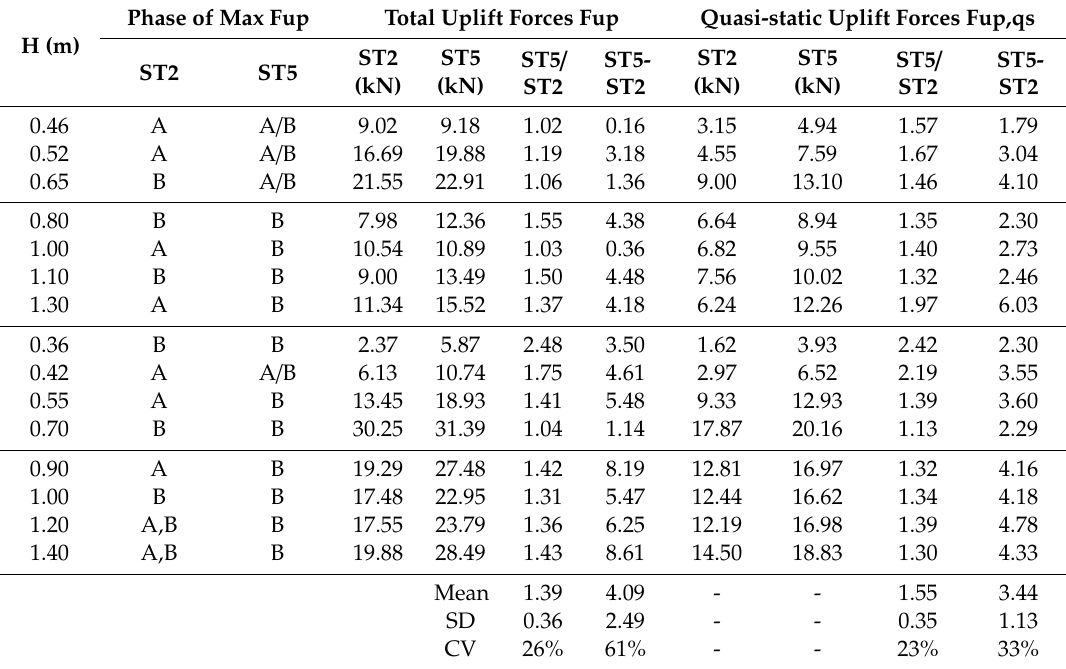
Table 4. Ratios of maximum total uplift forces of the deck with solid diaphragms (ST5) to the maximum values of the deck with cross-frames